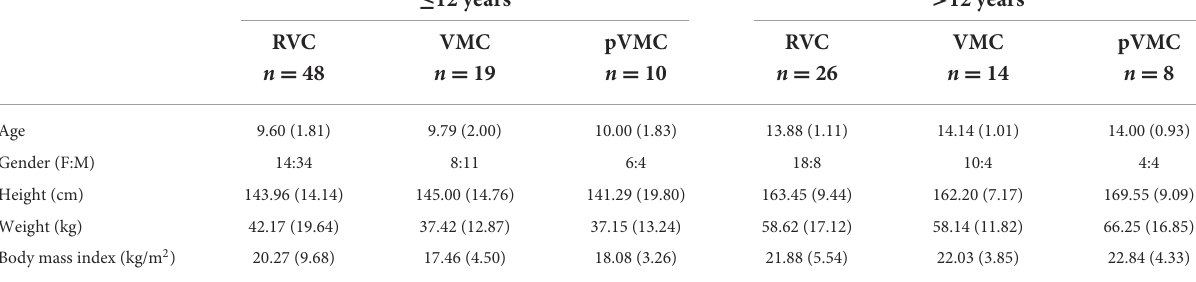
TABLE 1 Demographic details of the